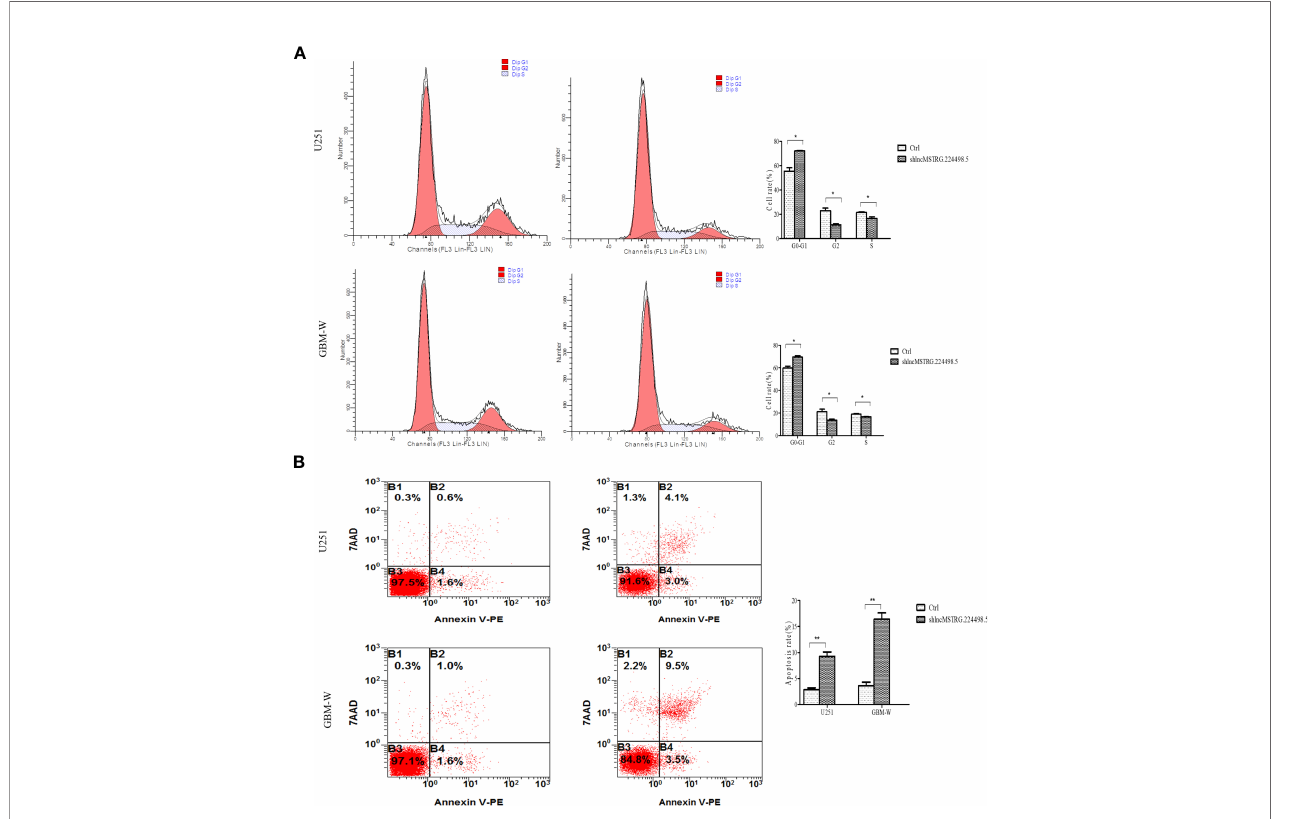
FIGURE 5 | LncRNAs MSTRG224498.5 can adjust the cell cycle and apoptosis of glioma cells. (A) Flow cytometry analysis of the cell cycle of U251 or GBM-W cells after transfection for 48 hours. (B) Flow cytometry analysis of the apoptosis rate of U251 or GBM-W cells after transfection for 48 hours. Results were presented as mean ± SD. * p < 0.05, ** p < 0.01.